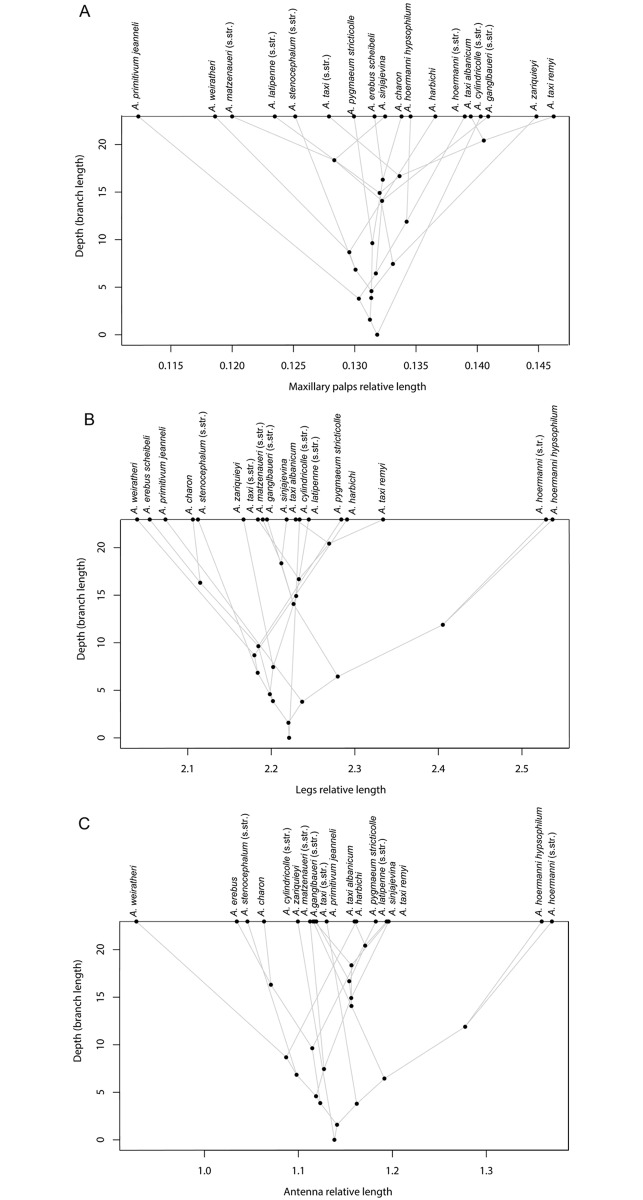
Evolution of the lengths of the appendages (completeness sake, the genus Graciliella is also included).A. Maxillary palps relative length; B. Legs relative length; C. Antenna relative length.